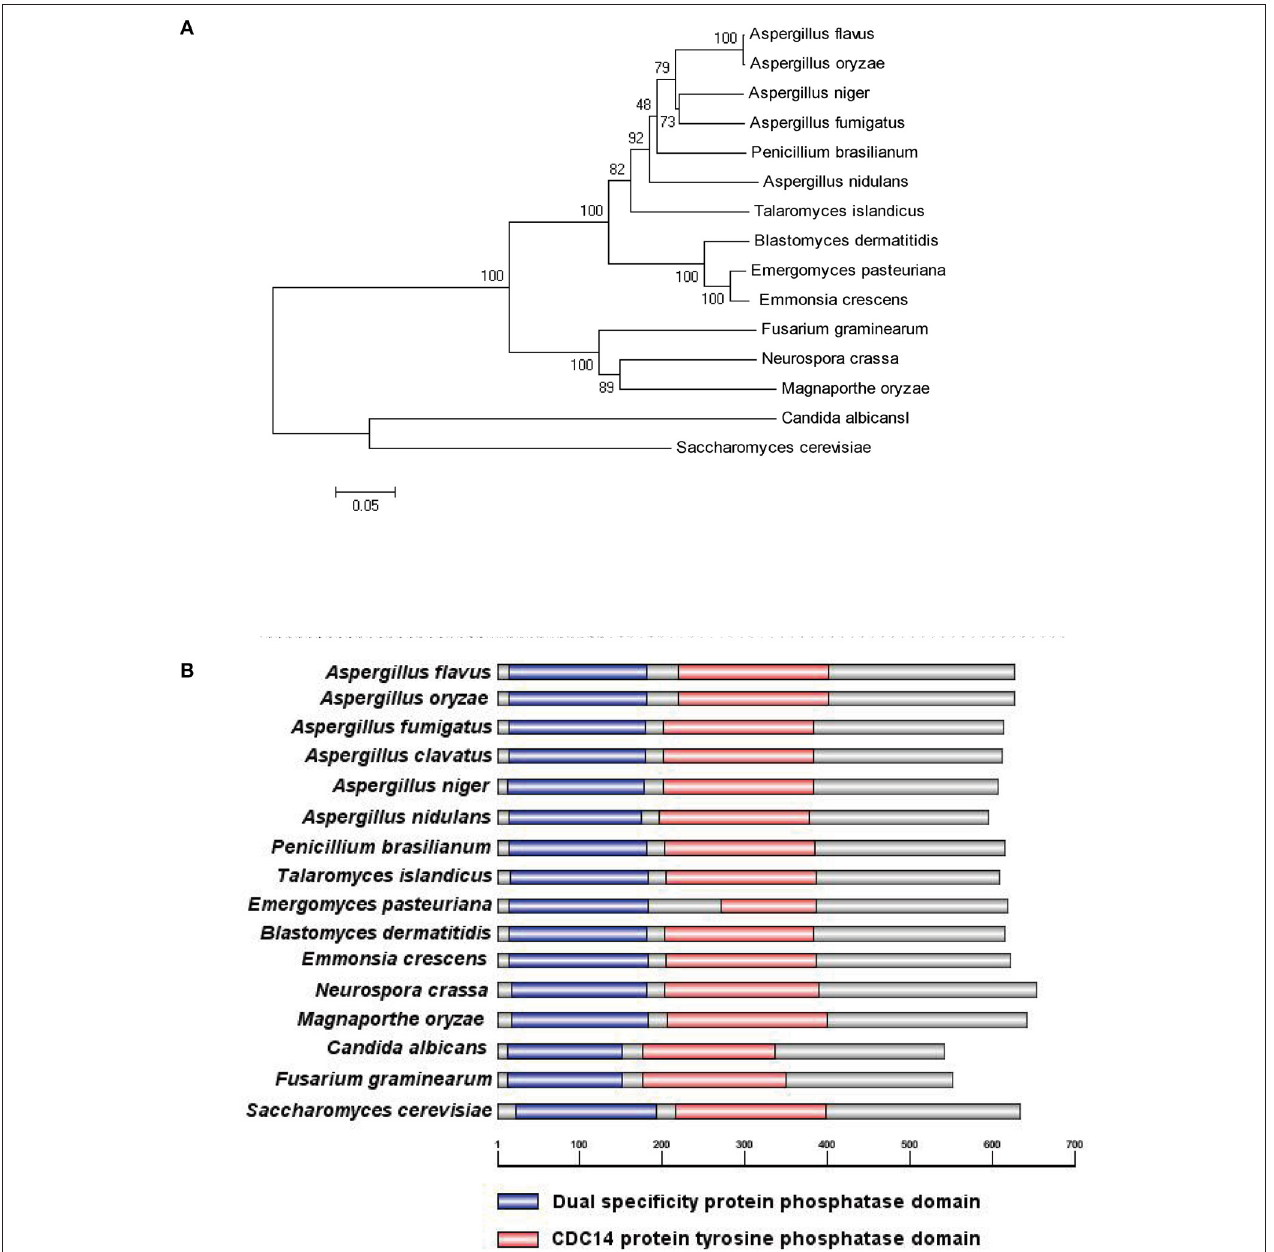
FIGURE 1 | Identification of phosphatase CDC14 in A. flavus . (A) Phylogenetic analysis of putative CDC14 phosphatase in different fungi. The phylogenetic tree was constructed by MEGA 5.0 software and the Neighbour-joining method with 1,000 replicate. (B) Domain structure analysis of putative CDC14 protein from different fungi. The dual specificity protein phosphatase domain is shown in blue, while the CDC14 protein tyrosine phosphatase domain is shown in